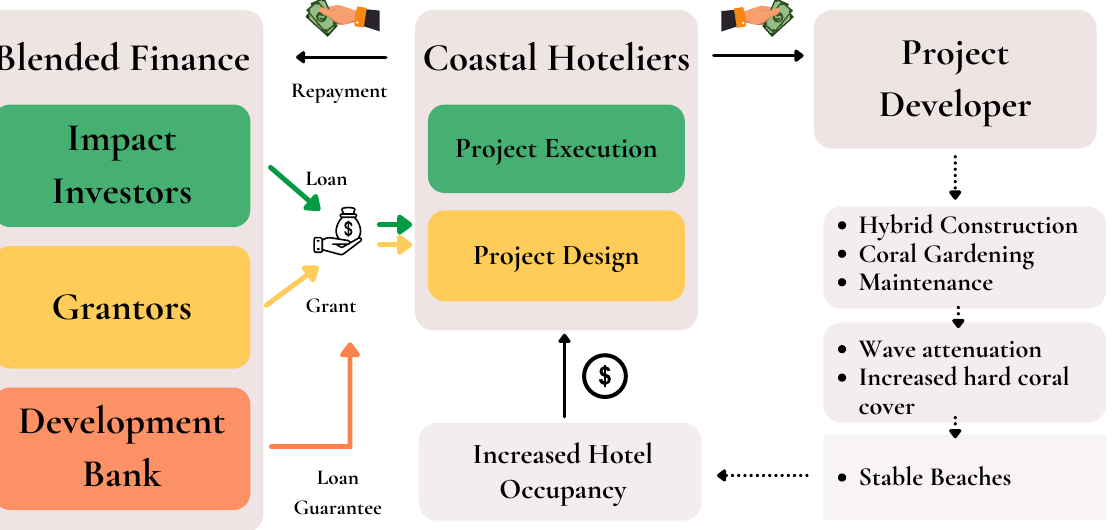
Figure 2. Potential blended finance investment model, with coastal hoteliers as recipients of